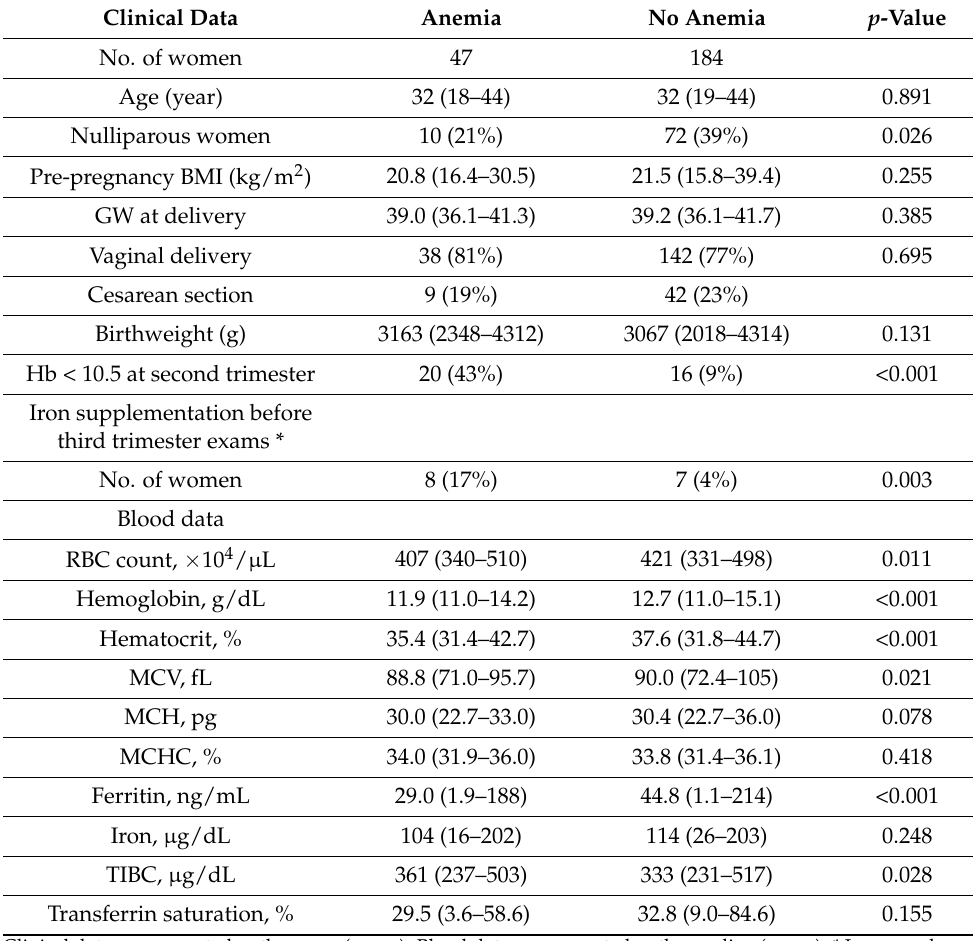
Table 3. Demographic characteristics and blood variables in anemic